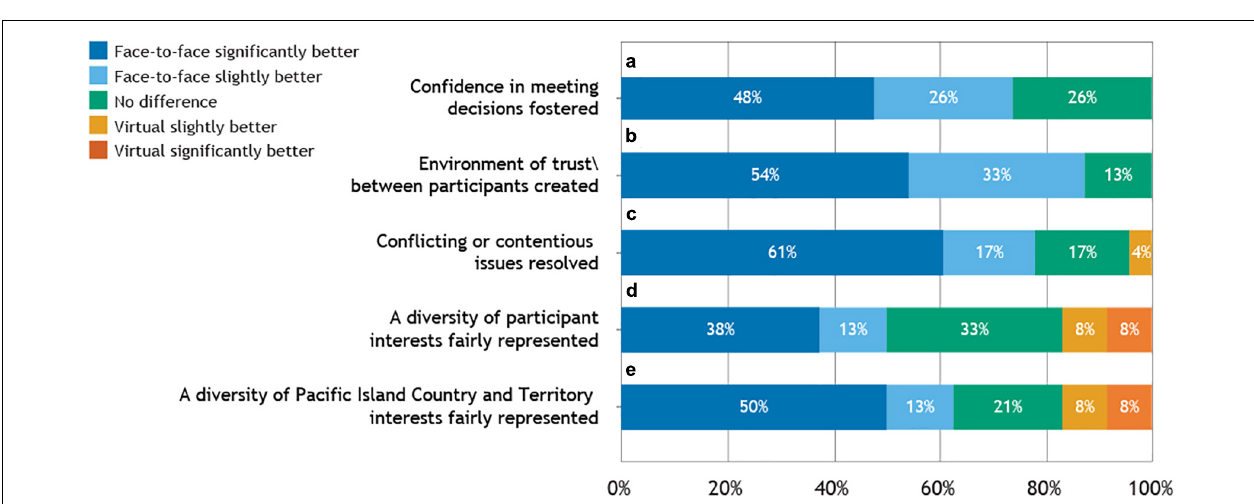
FIGURE 5 | Responses ( n = 24) to How would you rate the meeting formats (face-to-face or virtual) at supporting the following meeting